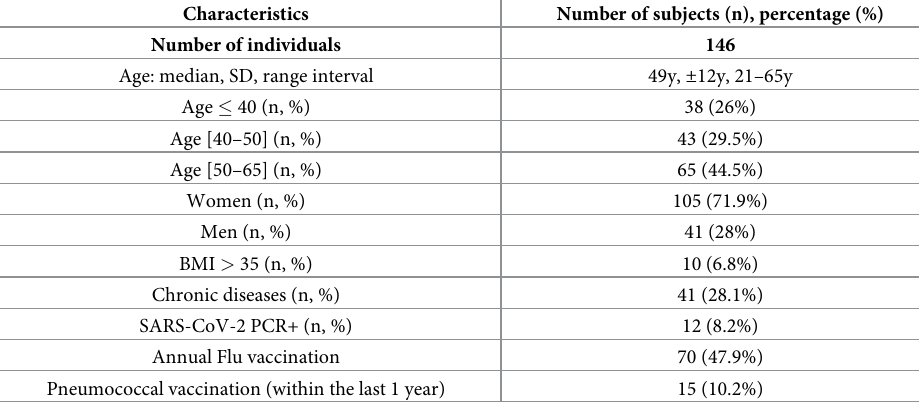
Table 1. Characteristics of individuals included in the study. Characteristics